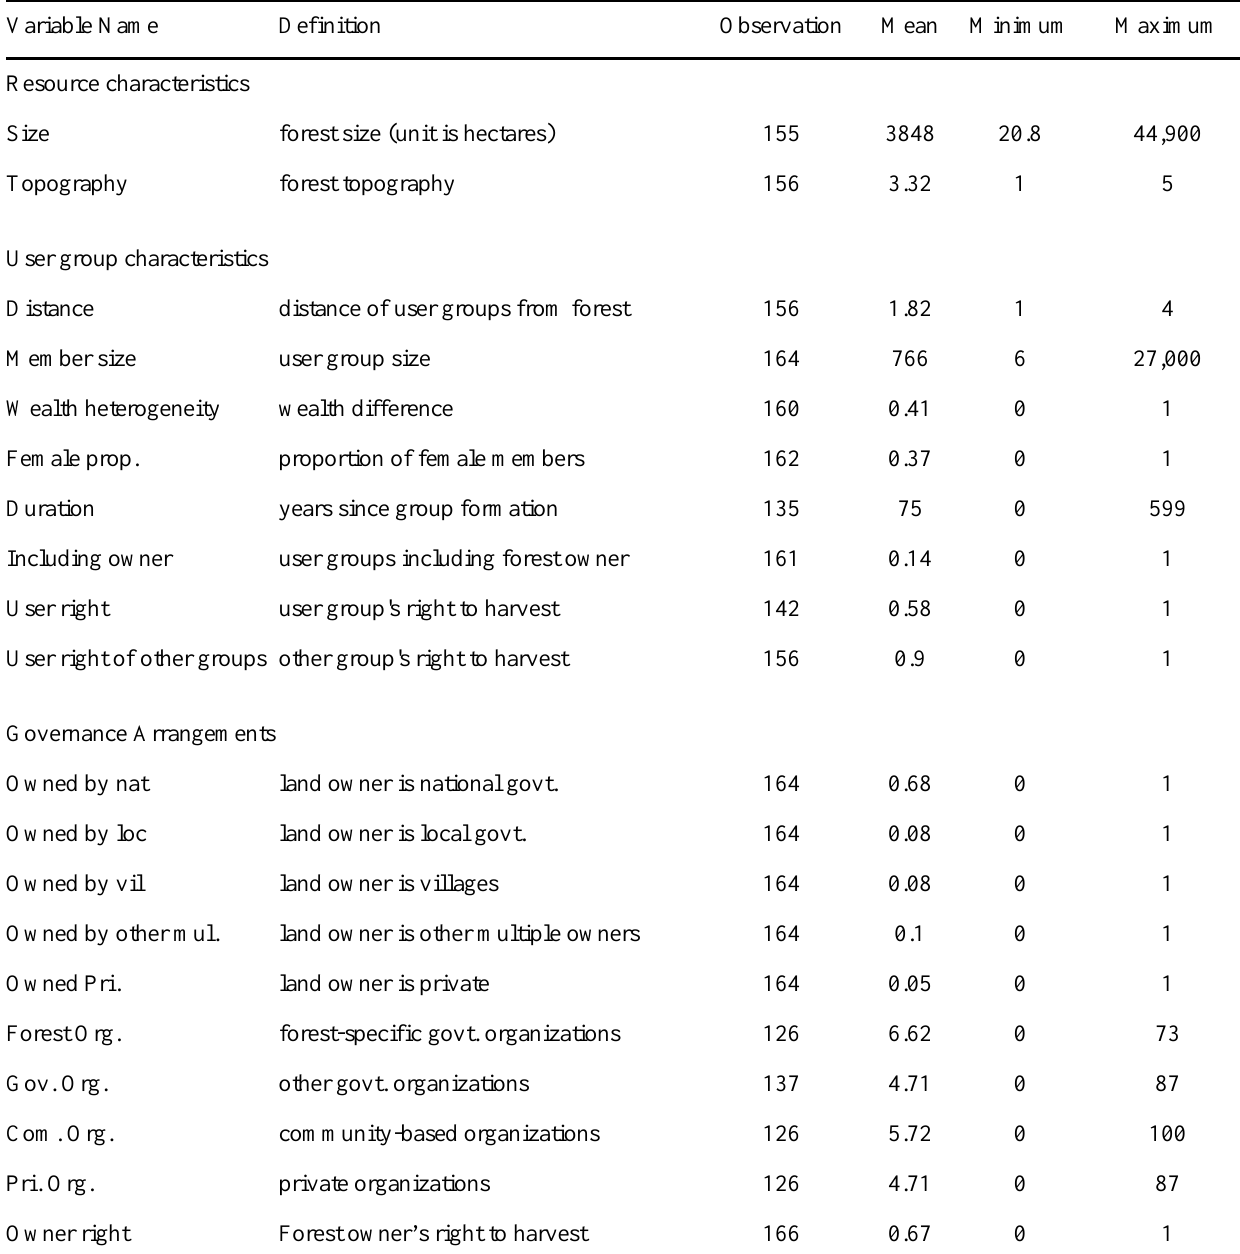
Table 2. Descriptive statistics of explanatory